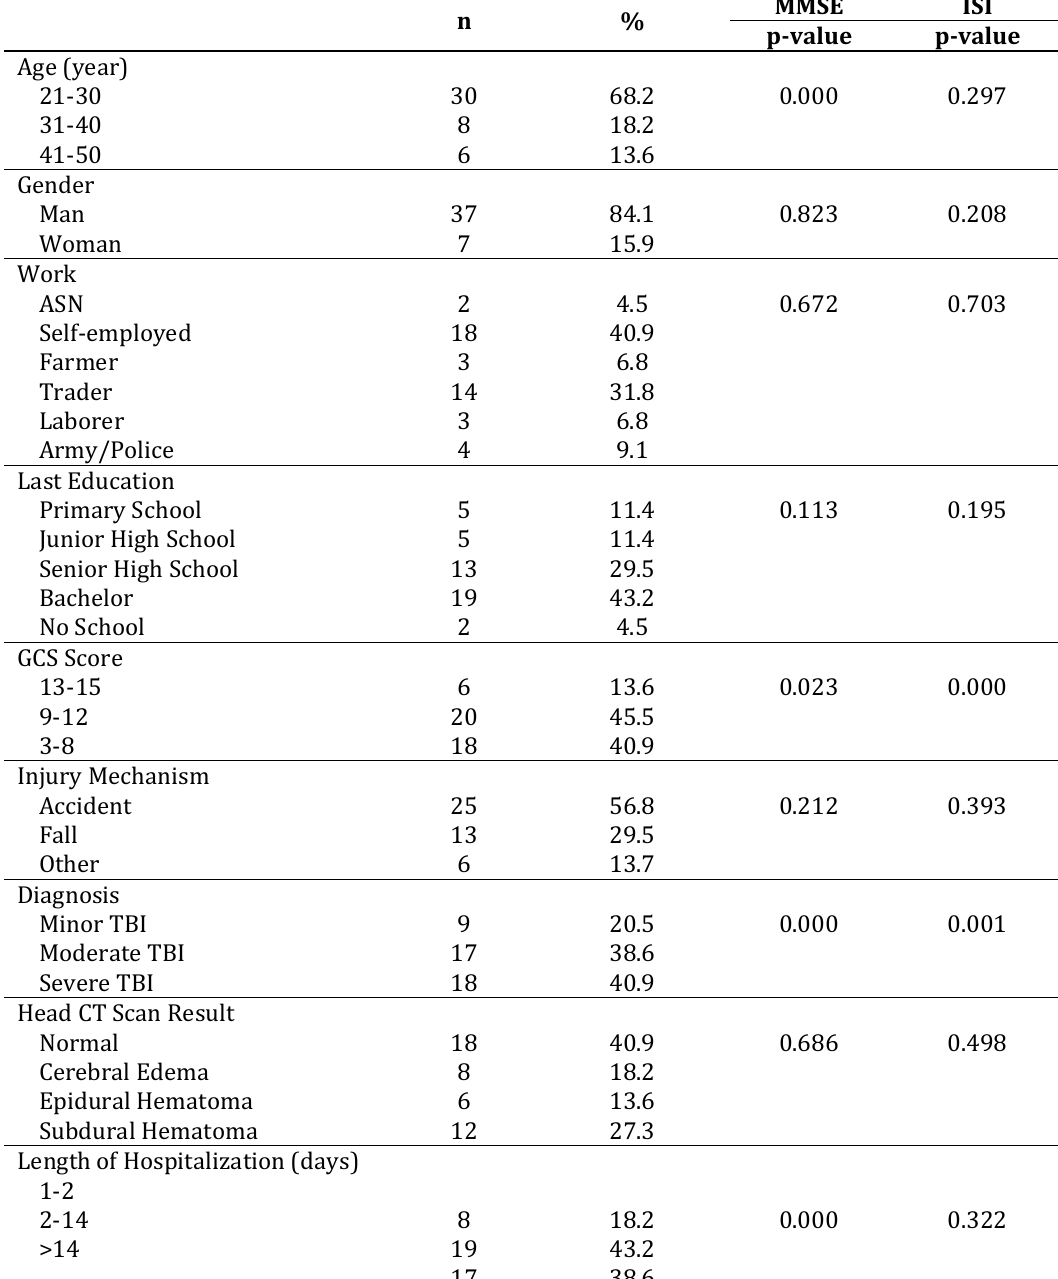
Table 1 Demographic Data and Statistical Test